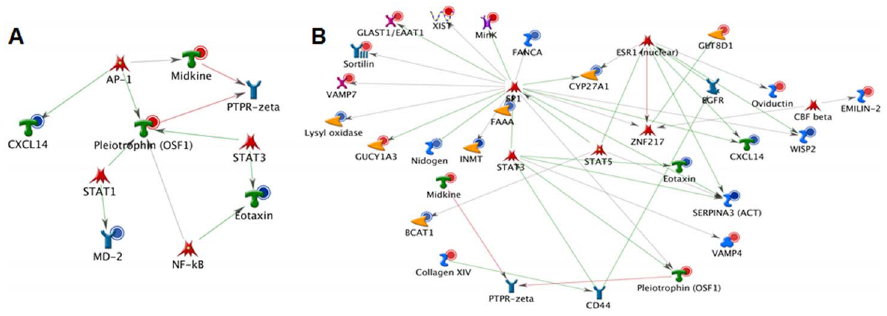
Figure 7. Network analysis of genes significant for sex: List of significant genes (root list) varying by sex was uploaded on to GeneGo tool and network was built. Receptor networks (A) was drawn using build network for your data option. Except receptors and receptor ligands, others were hidden from this network in order to visualize the alteration in receptor networks.. Transcription factor network (B) was drawn using analyze network function for transcription factors. In this analysis for every transcription factor with direct ligand (s) in the root list, the algorithm generates a sub-network consisting of all shortest paths from that transcription factor to the closest receptor with direct target (s) in the root list. The figure shows the differentially expressed genes in the network (Blue for down-regulated and Red for up-regulated).